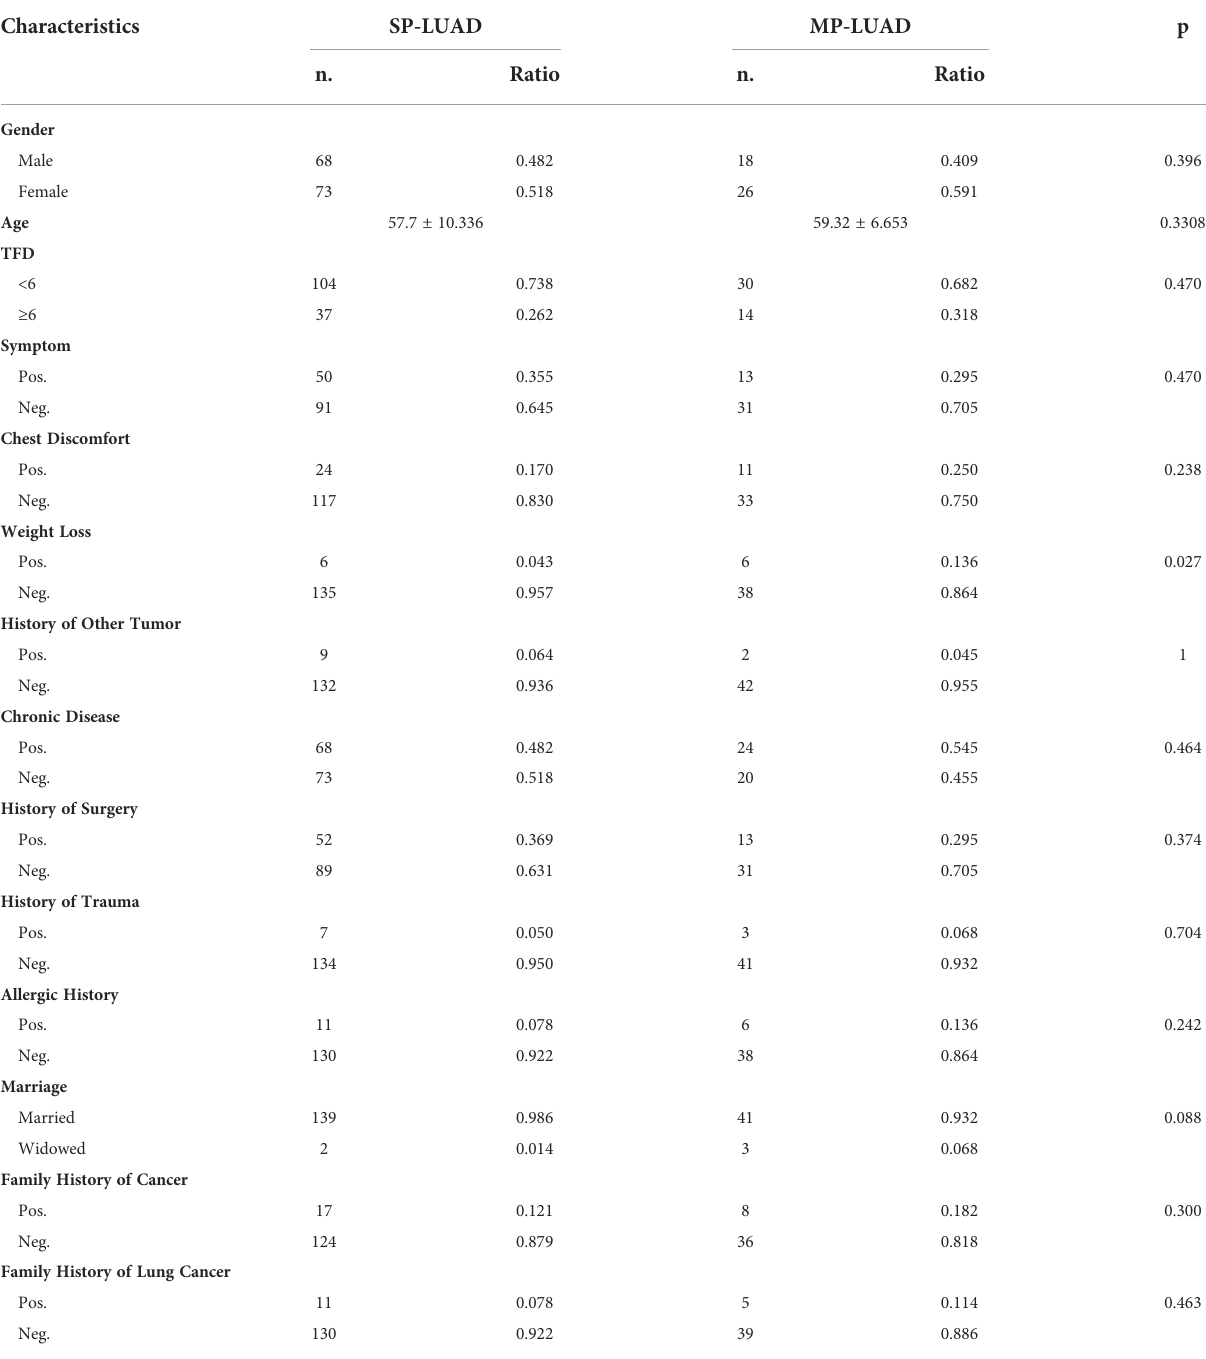
TABLE 1 Clinical characteristics of all